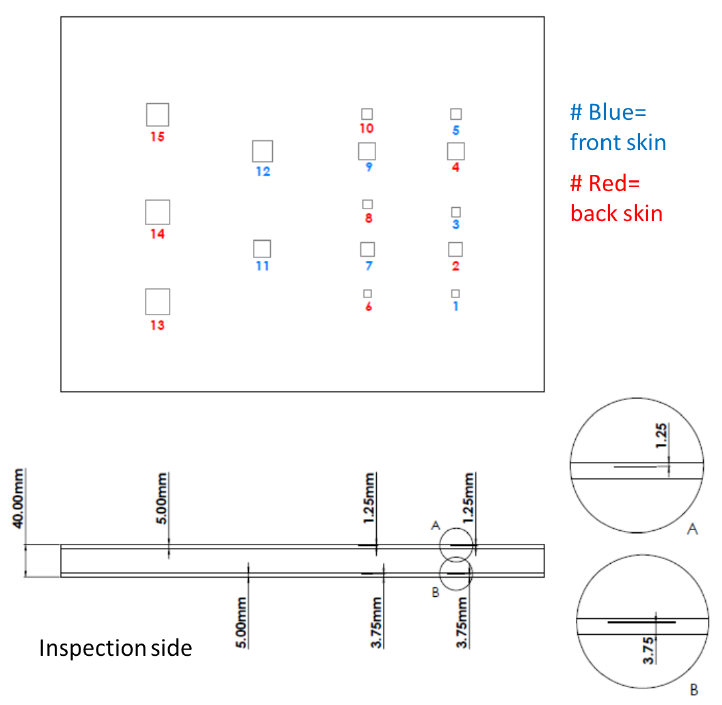
Figure 3. Schematic of sandwich sample. Table 3. Dimensions of the artificial Teflon defects for the monolithic sample.